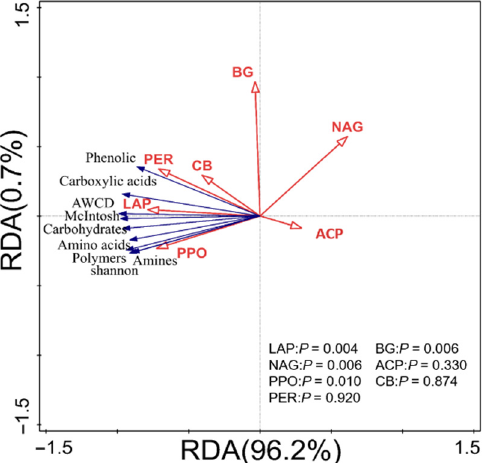
Figure 6. Redundancy analysis (RDA) between soil enzyme activities and microbial functional diversity.